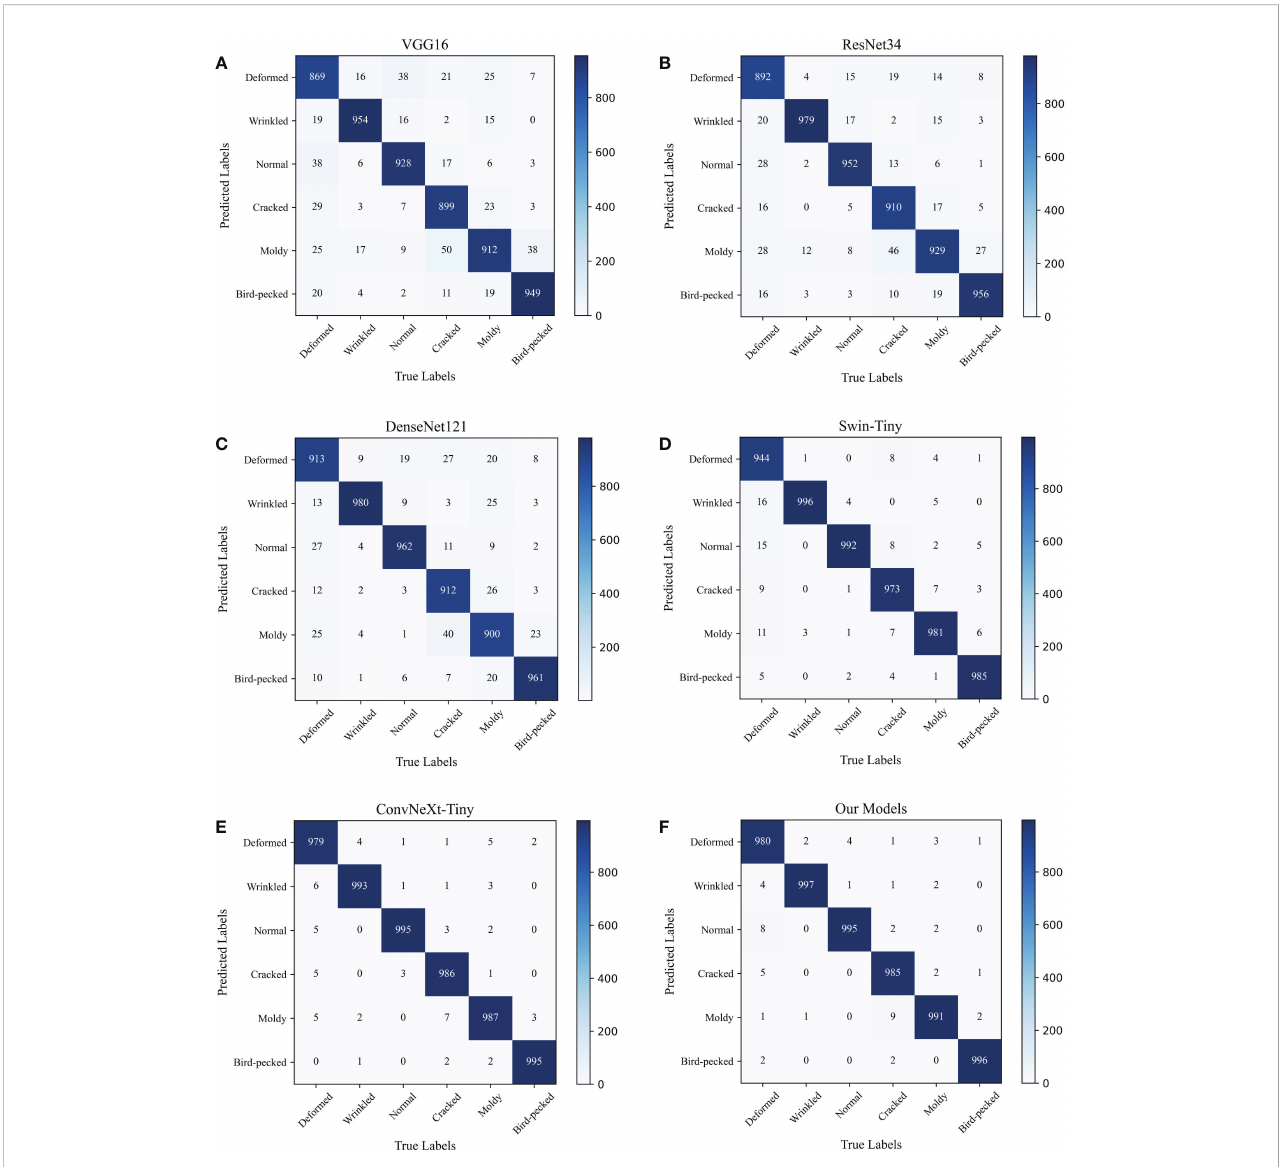
FIGURE 9 Confusion matrix for each model. (A) VGG16. (B) ResNet34. (C) DenseNet121. (D) Swin-Tiny. (E) ConvNeXt-Tiny. (F) The proposed